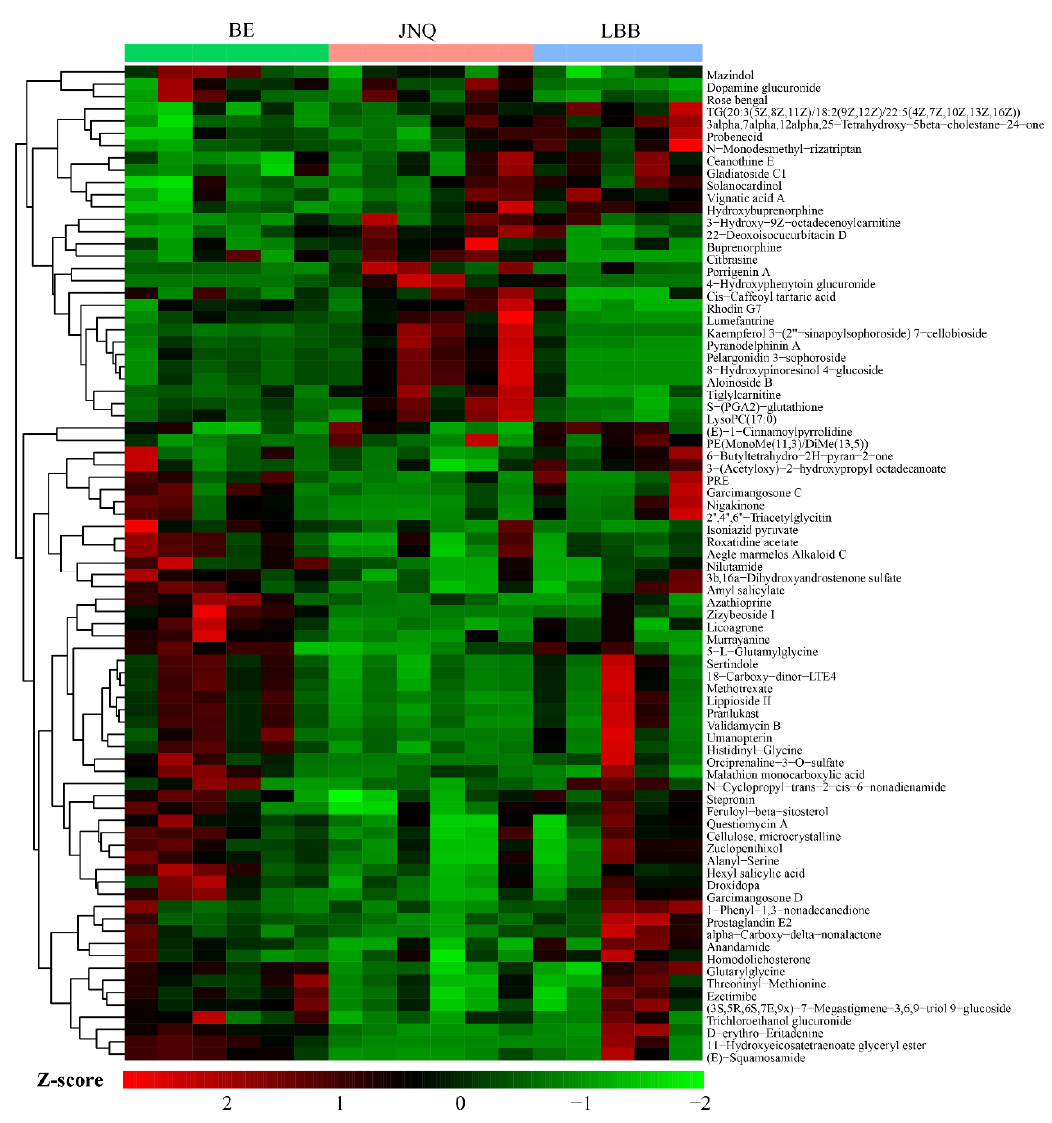
Figure 5. A clustered heat map based on all differential metabolites, which shows clear metabolic differences between the LBB group, JNQ group and BE group. The name of each differential metabolite is provided in the list to the right of the heat map.